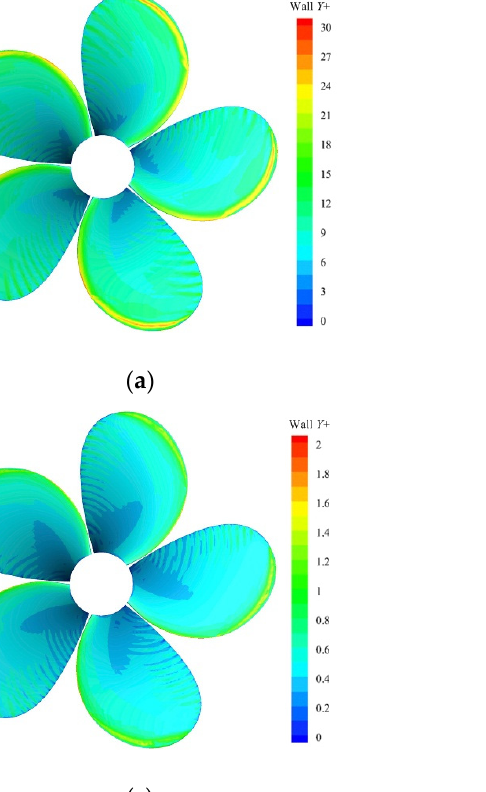
Figure 6. Effect of prism layer on vapor volume. 2.3. Modeling Physics The LES is an inherently transient technique in which the large scales of the turbulence are resolved everywhere in the flow domain, and the small-scale motions are modeled. Previously, many researchers have used the LES model to study the tip vortex on marine propellers, such as Lu et al. [30], Bensow [31] and Kumar and Mahesh [32]. Therefore, the LES model was used to investigate a winglet-propeller. The simulations were performed on two identical supercomputers. Each supercomputer consisted of 24 cores with Inter Xeon E5-2695 v3 (2.3 GHz) dual processors and 128 GB RAM. The Eulerian multiphase flow model and the Schnerr–Sauer cavitation model [33] were selected to implement the phase interaction. This cavitation model, which neglects the effect of bubble growth acceleration, viscous effects and surface tension effects, implements a reduced Rayleigh–Plesset equation. The values of the seed diameter and seed density are very important for the material properties of multiphase flow. Therefore, the analysis of these two parameters is necessary to ensure accurate simulation. The cavitation number σ is defined as 2 2 0.5 ref v p - p = n D σ ρ , (8) where ref p denotes the reference pressure and v p represents the vapor pressure of water, corresponding to the saturation pressure. The saturation pressure was selected as 2339 Pa (i.e., saturation temperature at about 20 °C) and the present study was conducted at σ = 2.0. Since an implicit unsteady solver was used for the analytical solution, the solution was related to the physical time. In addition, the adopted results of this paper were considered to be stable. Therefore, the influence of the physical time on the tip vortex wake is discussed. A time step of 1 × 10 − 4 s was selected to investigate the influence of the physical time. As illustrated in Figure 7, the